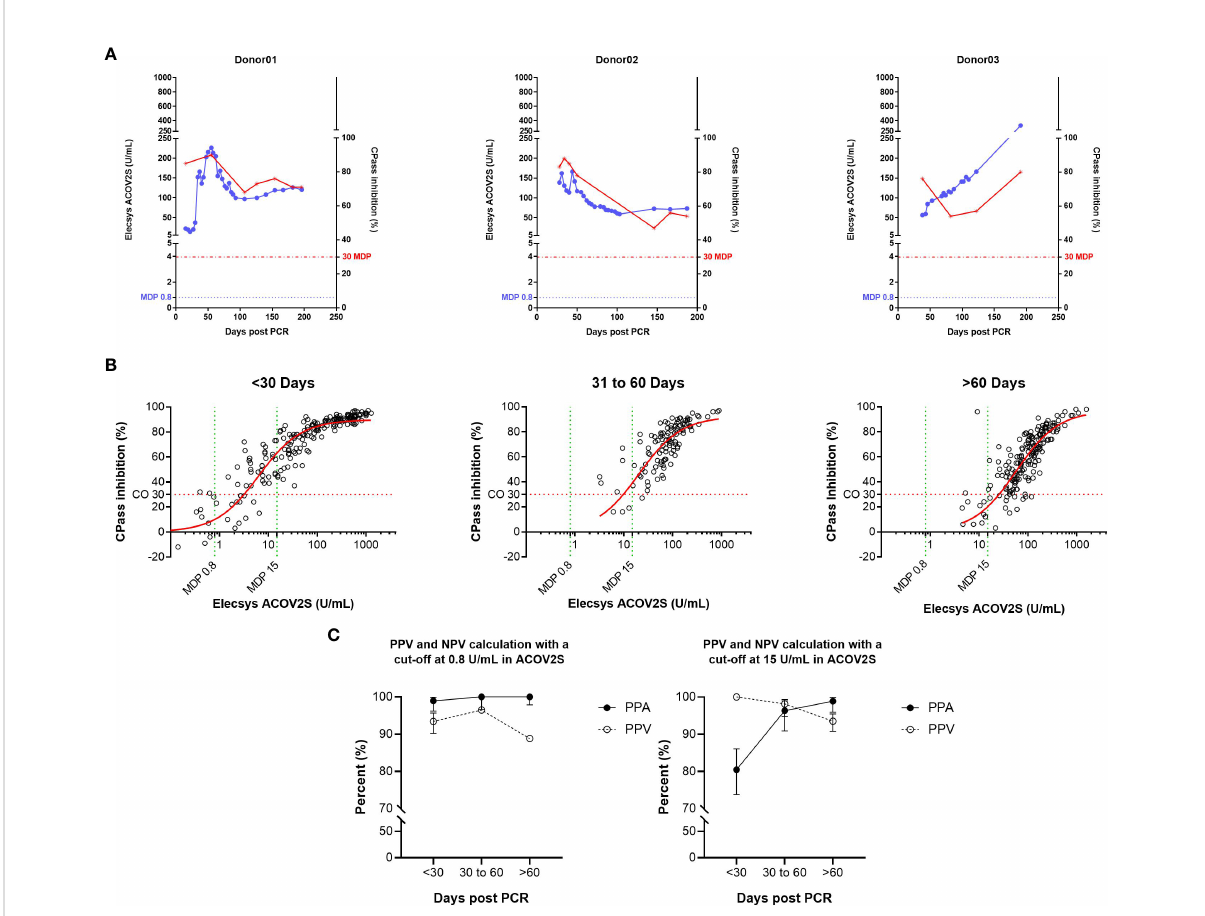
FIGURE 5 Correlation of the ACOV2S assay with results from the cPass neutralization assay. (A) ACOV2S titers and percentage inhibition from the cPass assay from longitudinal samples from exemplary selected individual donors, and (B) comparison of the ACOV2S and cPass results strati fi ed in time buckets after diagnostic PCR and (C) derived qualitative agreements. ACOV2S reactivity in samples with cPass inhibitory capacities is shown as positive percent agreement (PPA), cPass inhibitory capacity ACOV2S reactive samples is shown as positive predictive value (PPV). Analyses were carried out applying both, 0.8 U/mL and 15 U/mL as decision point for relevant ACOV2S reactivity. This analysis used native samples collected from convalescent donors at different timepoints after